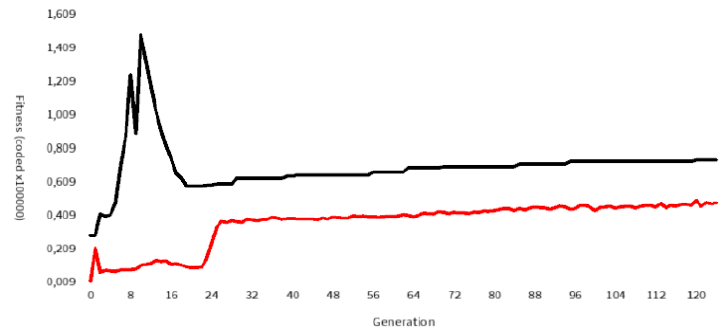
Figure 6: A graph representing the calculated fitness of the swarm population.